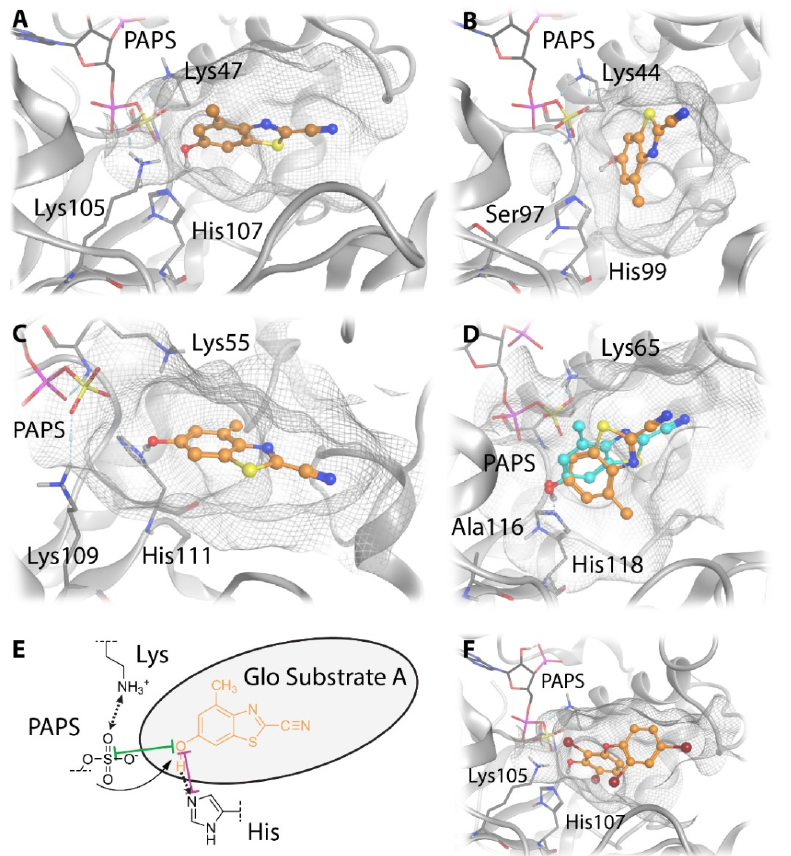
Figure 8. Suggested binding modes of GSA to four different SULT isoforms. ( A – D ) The most plausible docking poses of GSA to SULT1E1 ( A ), SULT2A1 ( B ), SULT4A1 ( C ), and SULT6B1 ( D ). ( E ) Distances of the hydroxy group of GSA to the catalytic histidine and the cofactor PAPS are displayed in a 2D substrate pocket depiction. ( F ) The X-ray binding mode of the co-crystallized ligand 2,6-dibromo-3- (2,4-dibromophenoxy) phenol to SULT1E1 is shown for comparison (PDB-id: 4JVN). However, the catalytic histidine and cofactor-binding lysine are highly conserved in all four SULT isoforms, and differences in the third key residue position do not rationalize the observed